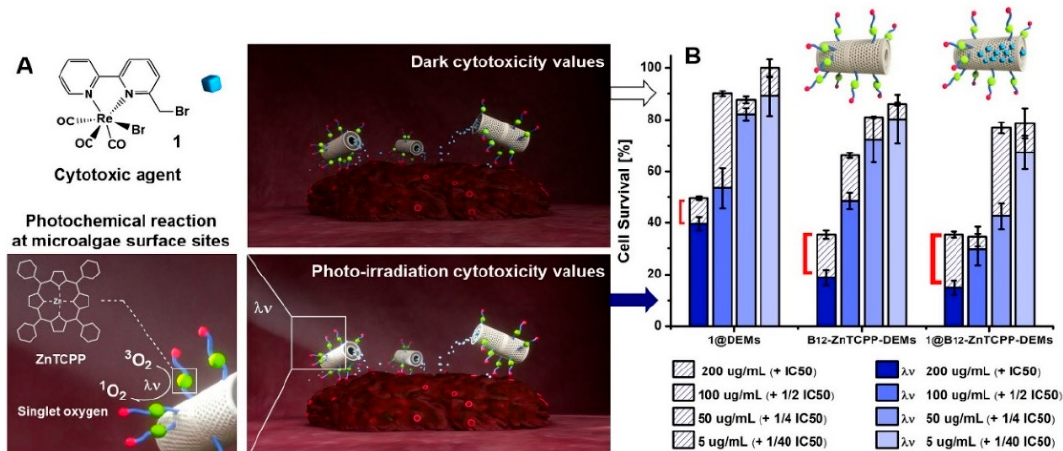
Figure 5. ( A ) Conceptual representation of the experiment, structure of complex 1 and detail of the photochemical reaction taking place at the microalgae surface sites (ZnTCPP-induced 1 O 2 generation). ( B ) Histograms representing the effects on HCT-116 colorectal cancer cells % survival by different doses of 1 @DEMs, B 12 -ZnTCPP-DEMs and 1 @B 12 -ZnTCPP-DEMs when administered in the dark (empty bars) and under the same conditions following light activation of the microalgae surface (filled colored bars). The red square brackets on the graph are meant to highlight the enhanced cytotoxicity of the material upon photo-irradiation.